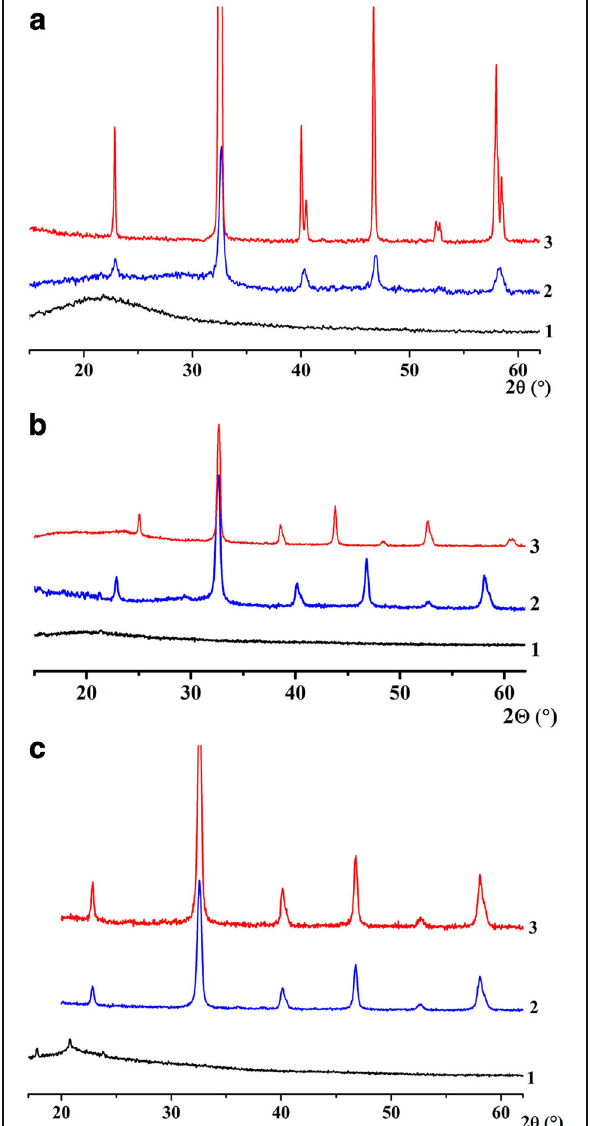
Fig. 1 XRD data for LSMO nanoparticles, synthesized via sol-gel method ( a ), by precipitation from DEG solution ( b ), and by precipitation from reversal microemulsions ( c ): 1 – 200 °C, 2 – 600 °C, and 3 – 800